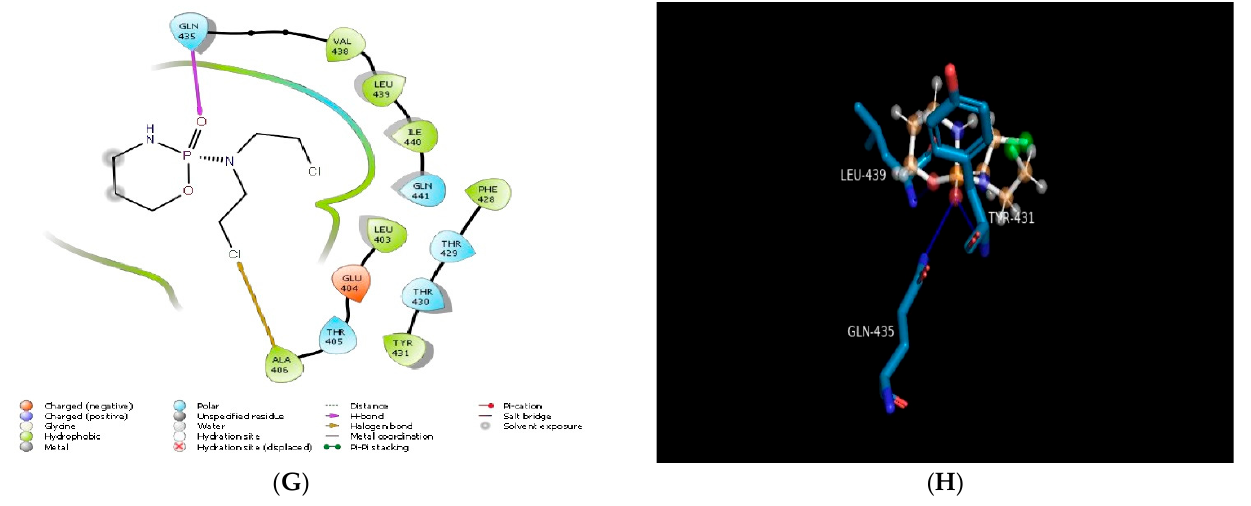
Figure 1. Molecular docking of compounds with heat shock protein (PDB ID: 4PO2): ( A ) 2D schematic diagram showing interactions of quercetin. ( B ) Cartoon view of heat shock protein with quercetin. ( C ) 2D schematic diagram showing interactions of carpaine. ( D ) Cartoon view of heat shock protein with carpaine. ( E ) 2D schematic diagram showing interactions of imipenem (standard). ( F ) Cartoon view of heat shock protein with imipenem (standard). ( G ) 2D schematic diagram showing interactions of cyclophosphamide (standard). ( H ) Cartoon view of heat shock protein with cyclophosphamide (standard). Residues involved in hydrogen bonding, van der Waals interactions, carbon–hydrogen, and pi–alkyl are represented in different colours indicated in the inset. Table 1. Detailed information on molecular docking of bacterial proteins with the test and standard compounds.